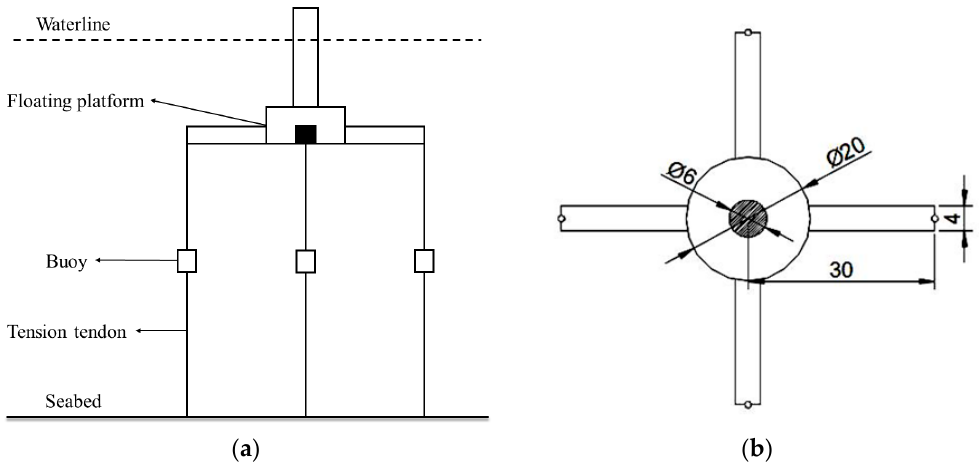
Figure 1. Sketch of the Serbuoys-TLP: ( a ) front view; ( b ) top view (units: m). Compared with the massless spring model and the nonlinear beam model, the lumped mass method can fully consider the wave–current load on the floating platform and the tension tendon. It is suitable for the hinged connection between the buoy and the mooring system, so the tendon is simplified to a three-dimensional lumped mass in this method [30,31]. After the model divides the entire tension tendon into n segments, each segment is equivalent to a massless spring, represented by Si (i = 1, …, n ), each segment is connected by a mass node, and each node is represented by i (i = 1, …, n ). Figure 2 takes a single tendon as an example to show the segmentation of the tendons.